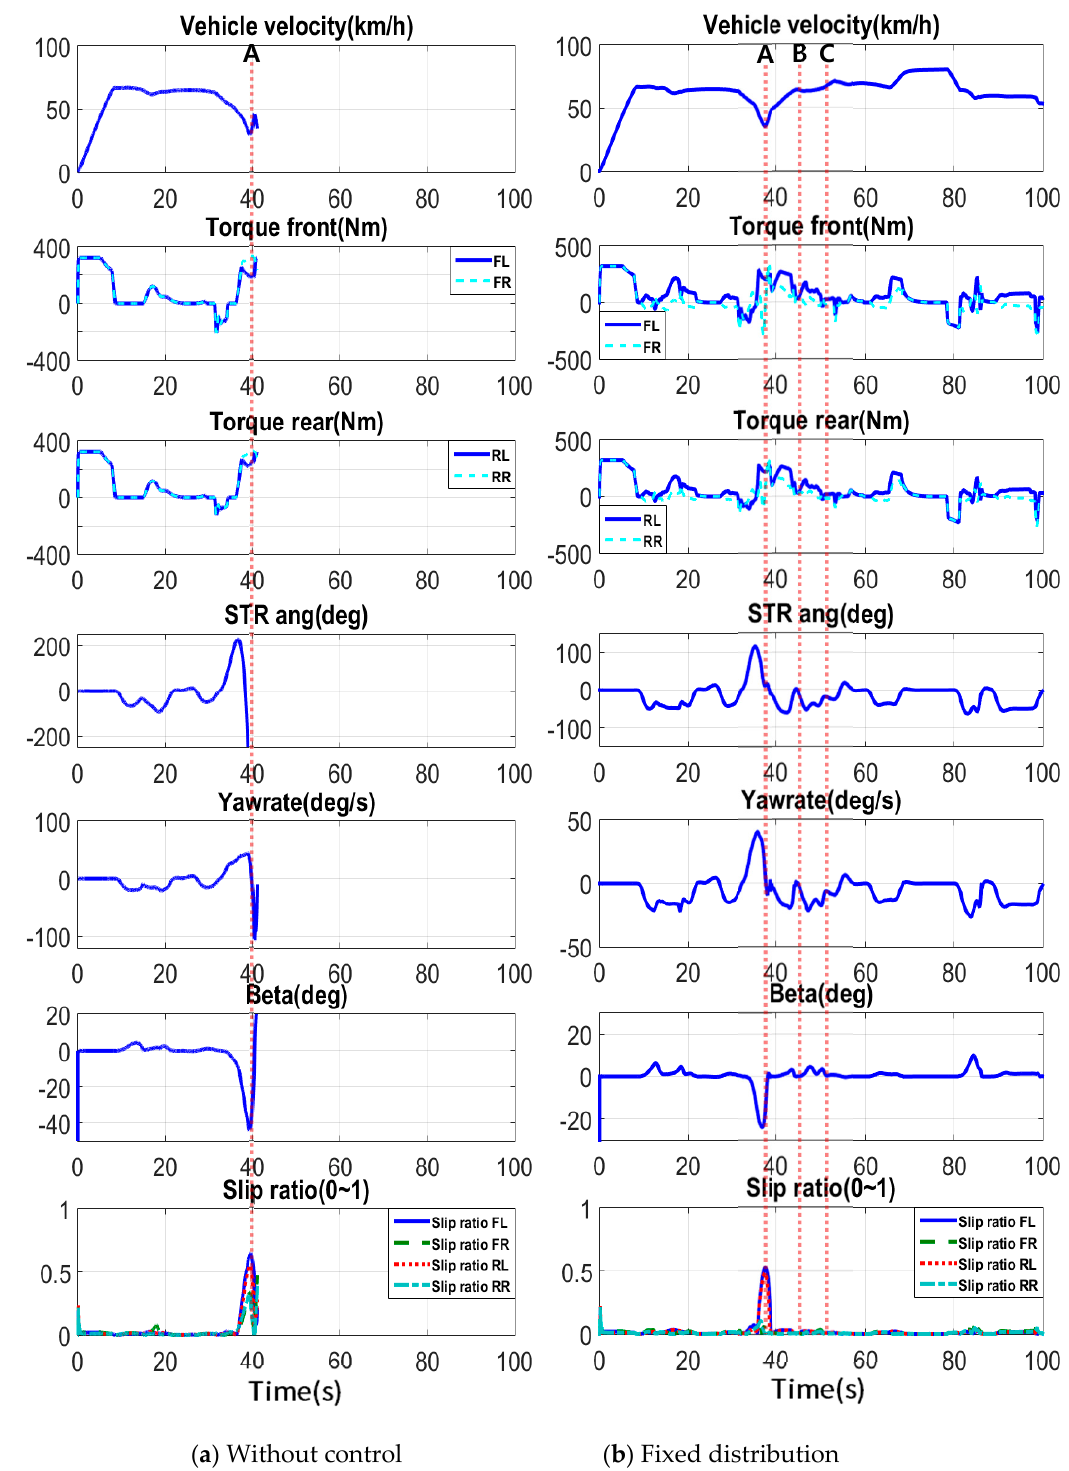
Figure 13. Simulation results for complex driving road (No control, Fixed distribution).